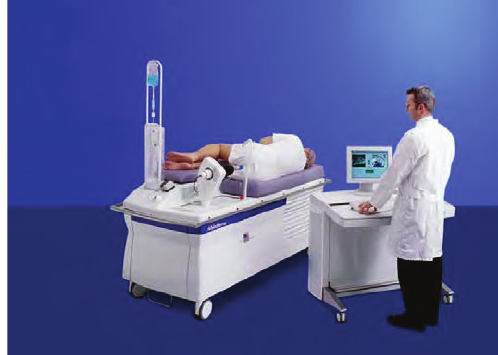
Figure 1: HIFU computerized surgical device.